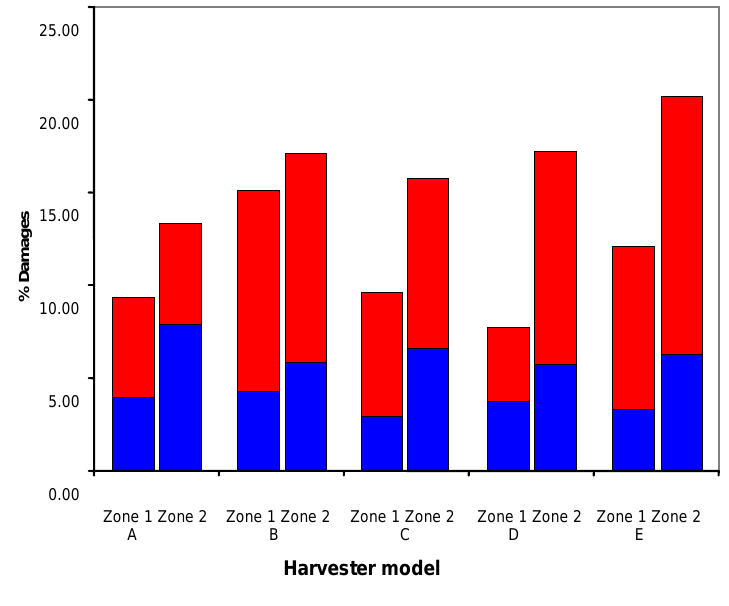
Figure 9. Total damages registered per harvester and zone:  % broken;  % cracked. Zone 1: combine elements from cutting device to second belt. Zone 2: combine elements from second belt to loading onto the trailer. Cracked tomatoes with only skin damages. Broken tomatoes with deep